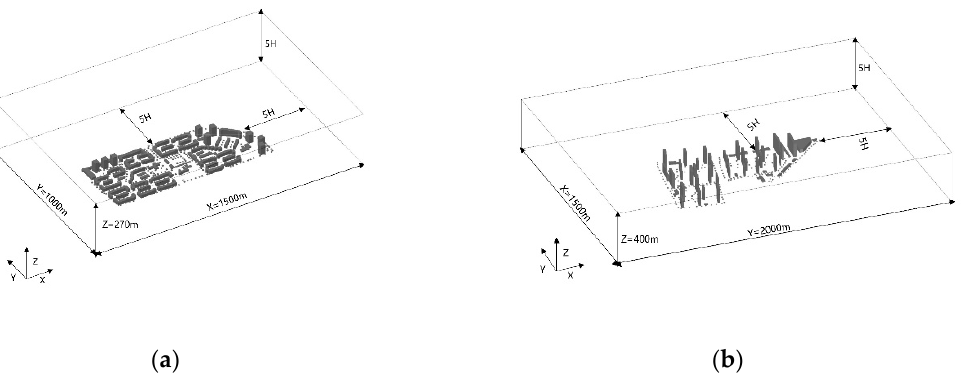
Figure 2. Computing domain construction of neighborhoods: ( a ) Neighborhood A; ( b ) Neighborhood B.